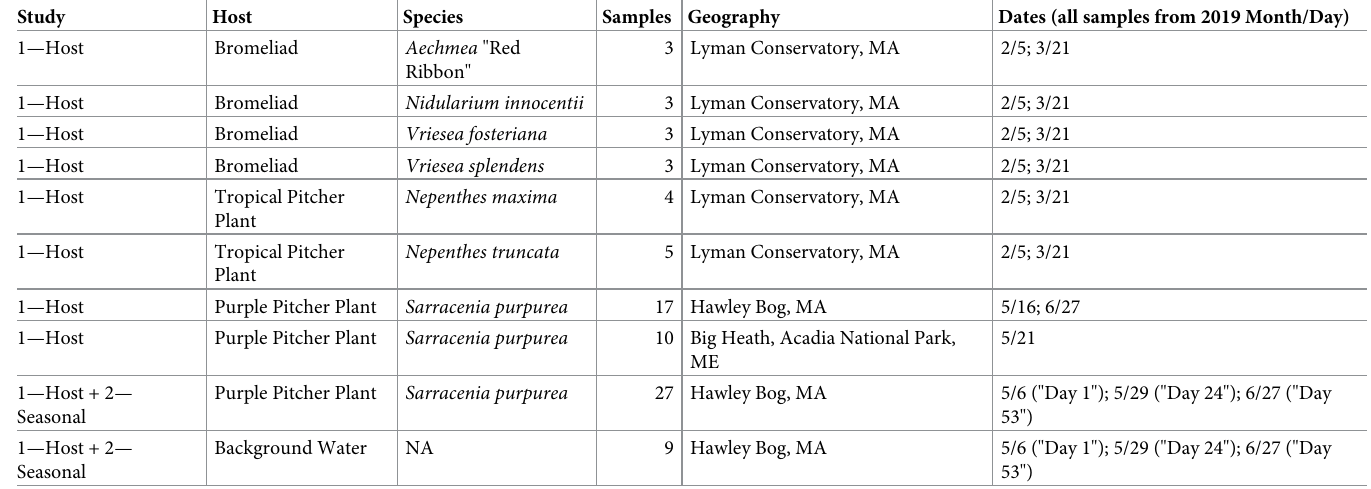
Table 1. Study and sampling